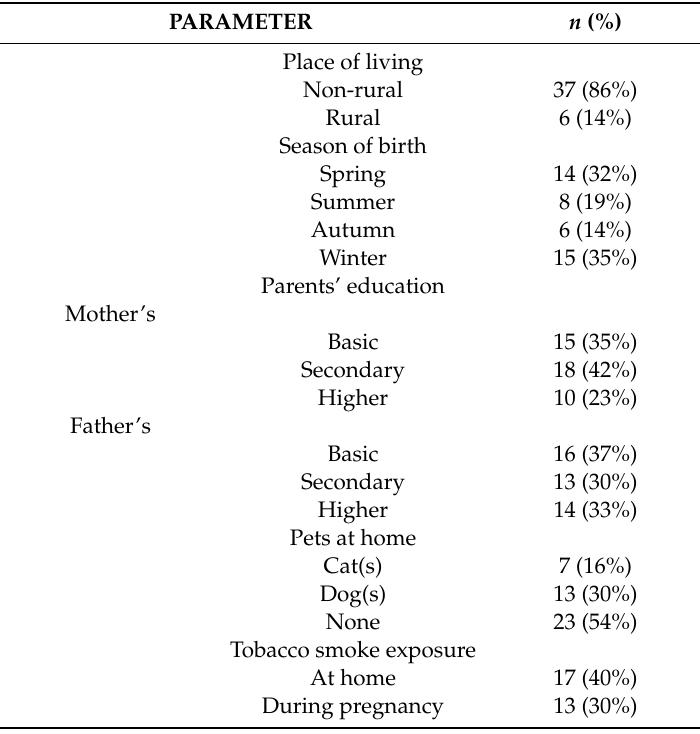
Table 2. Socio-economic status (SES) of included